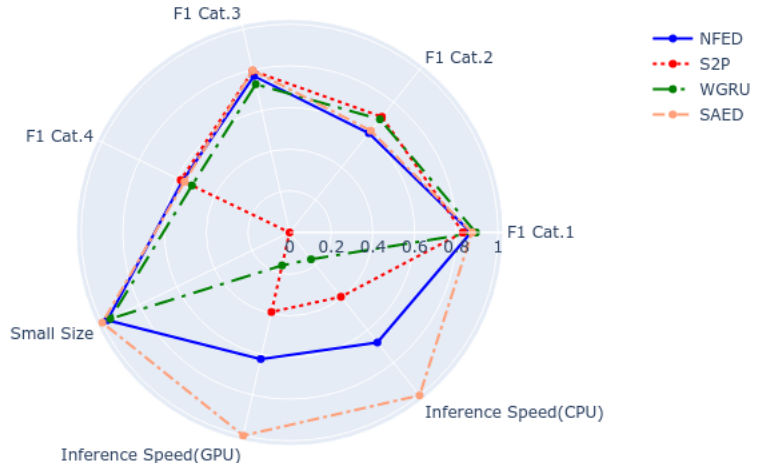
Figure A3. Diagram that summarizes the capabilities of the models to disaggregate a microwave.